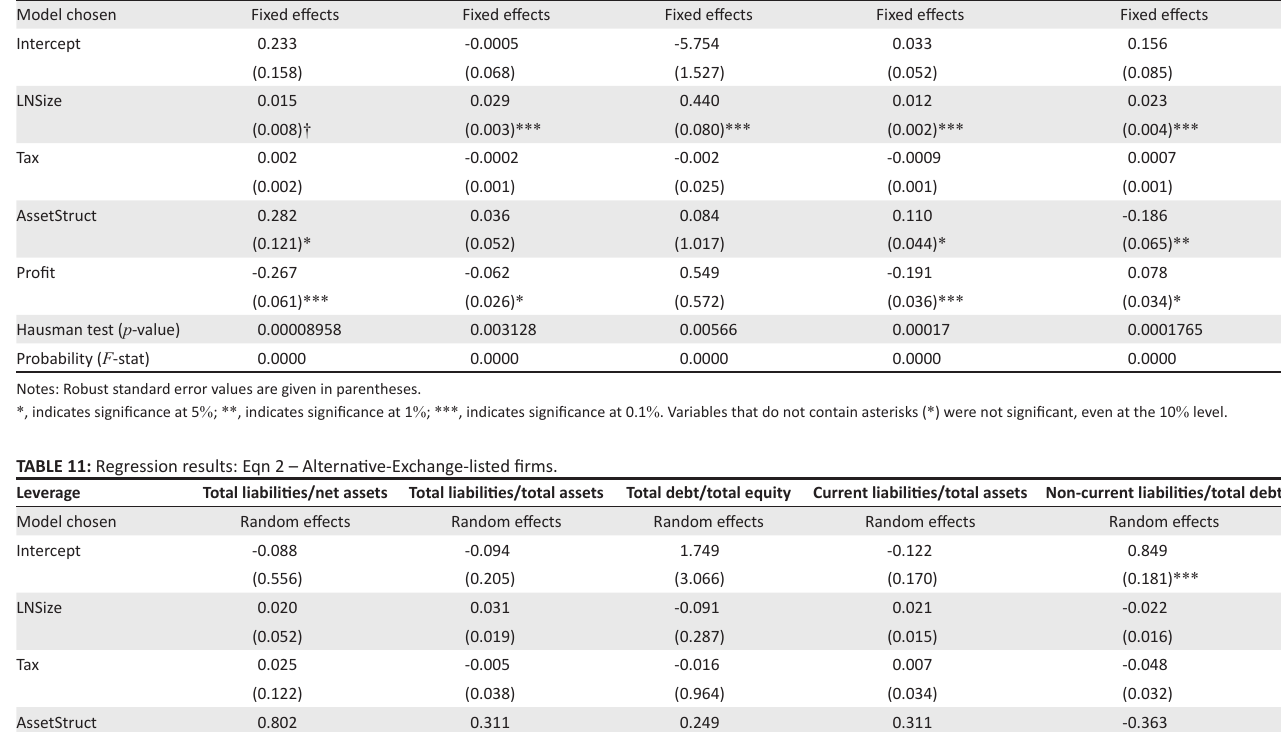
TABLE 10: Regression results: Eqn 2 – Johannesburg Securities Exchange–listed firms.